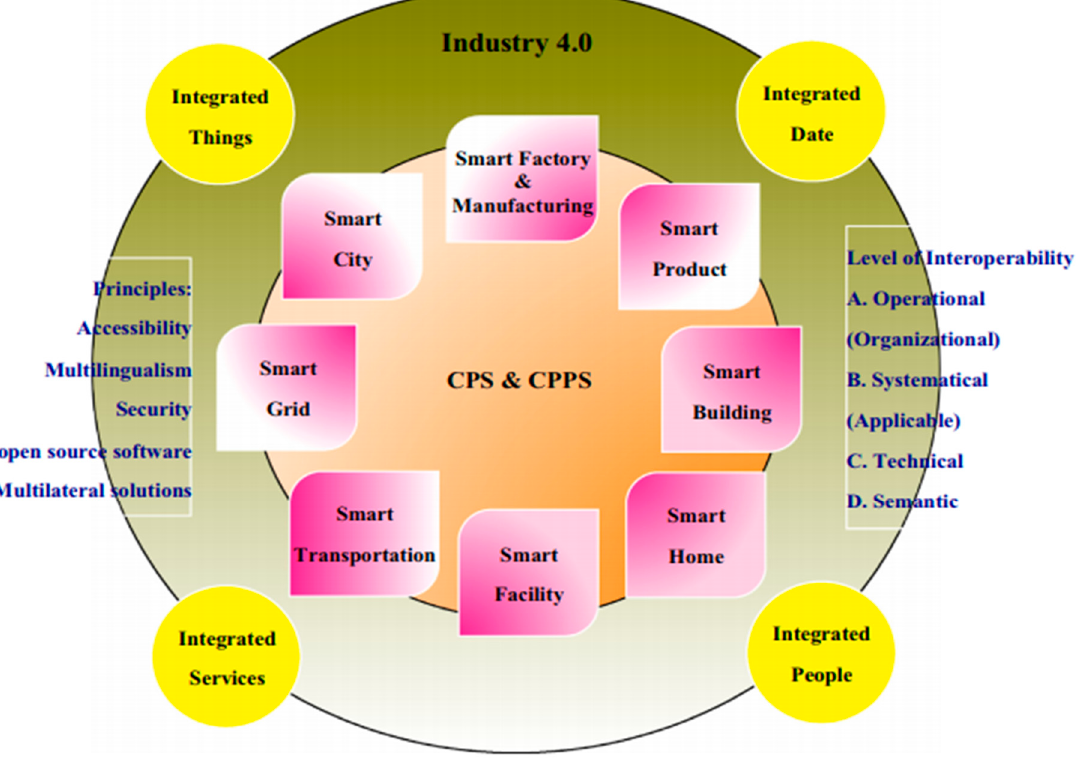
Figure 4. Framework of interoperability: How it facilitates the production and services sectors. Source: Lu (2017).